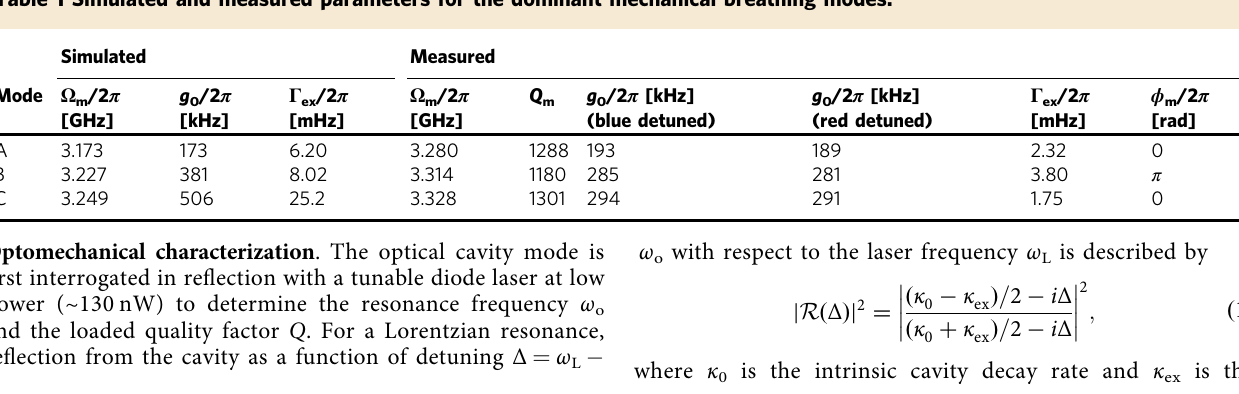
Table 1 Simulated and measured parameters for the dominant mechanical breathing modes. Simulated Measured Mode Ω m /2 π [GHz]